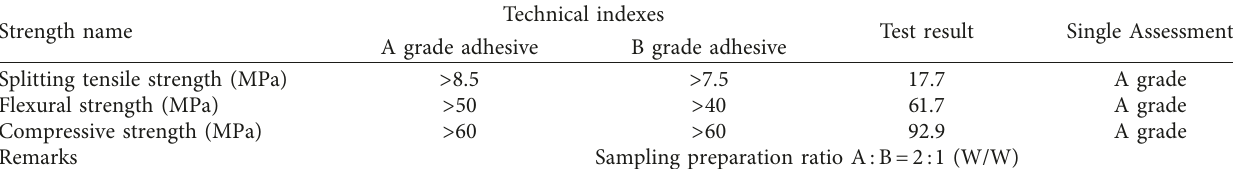
Table 4: Properties of high-strength epoxy